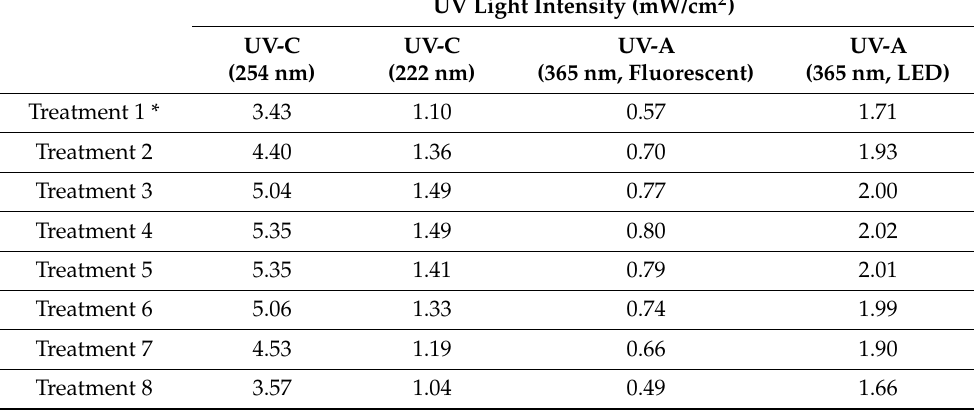
Table 1. Average UV light intensity for each treatment (quartz tube #) was measured without tube shielding. In the experiment, the quartz tubes were covered with different lengths of polyvinyl chloride (PVC) pipes to control the UV dose, and thus, the effective light intensity was estimated for each treatment